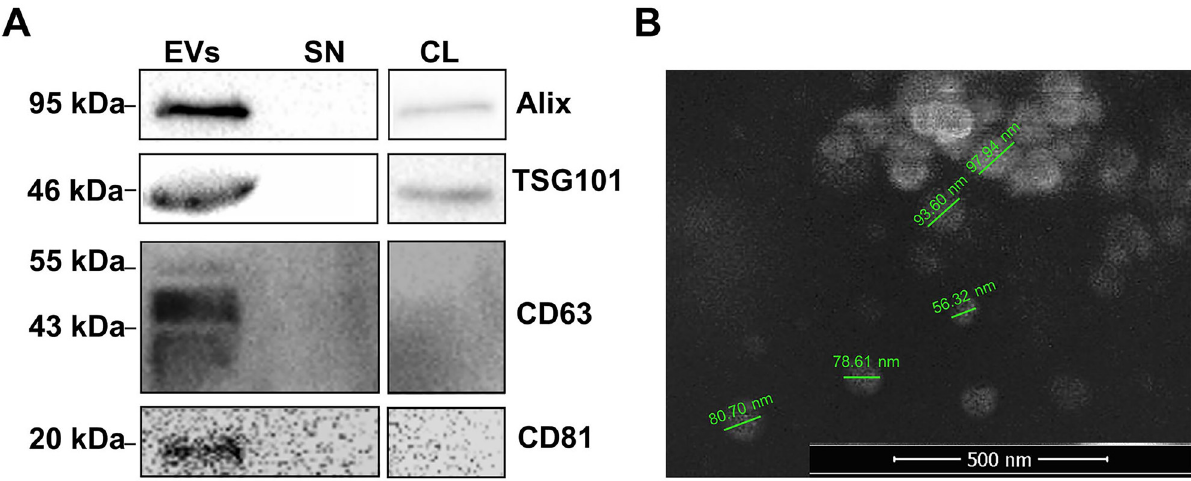
Figure 3: Identification of EVs released from U87MG by Western blotting and SEM imaging. A) Western blot analysis demonstrated expressions of EV marker proteins in extracellular vesicles released from glioblastoma cells. B) The characterization of EVs were performed using Scanning electron microscope (SEM). Original magnification × 50,000. The bar 500 nm. Extracellular vesicles (EVs), Supernatant (SN), Cell Lysate